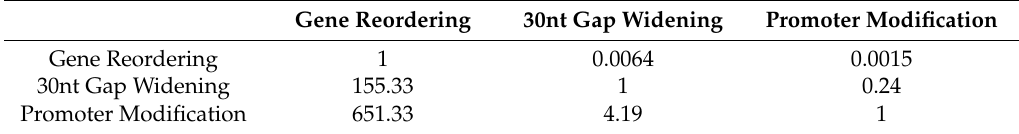
Table 1. Relative rates of evolution of these three modes of OLS